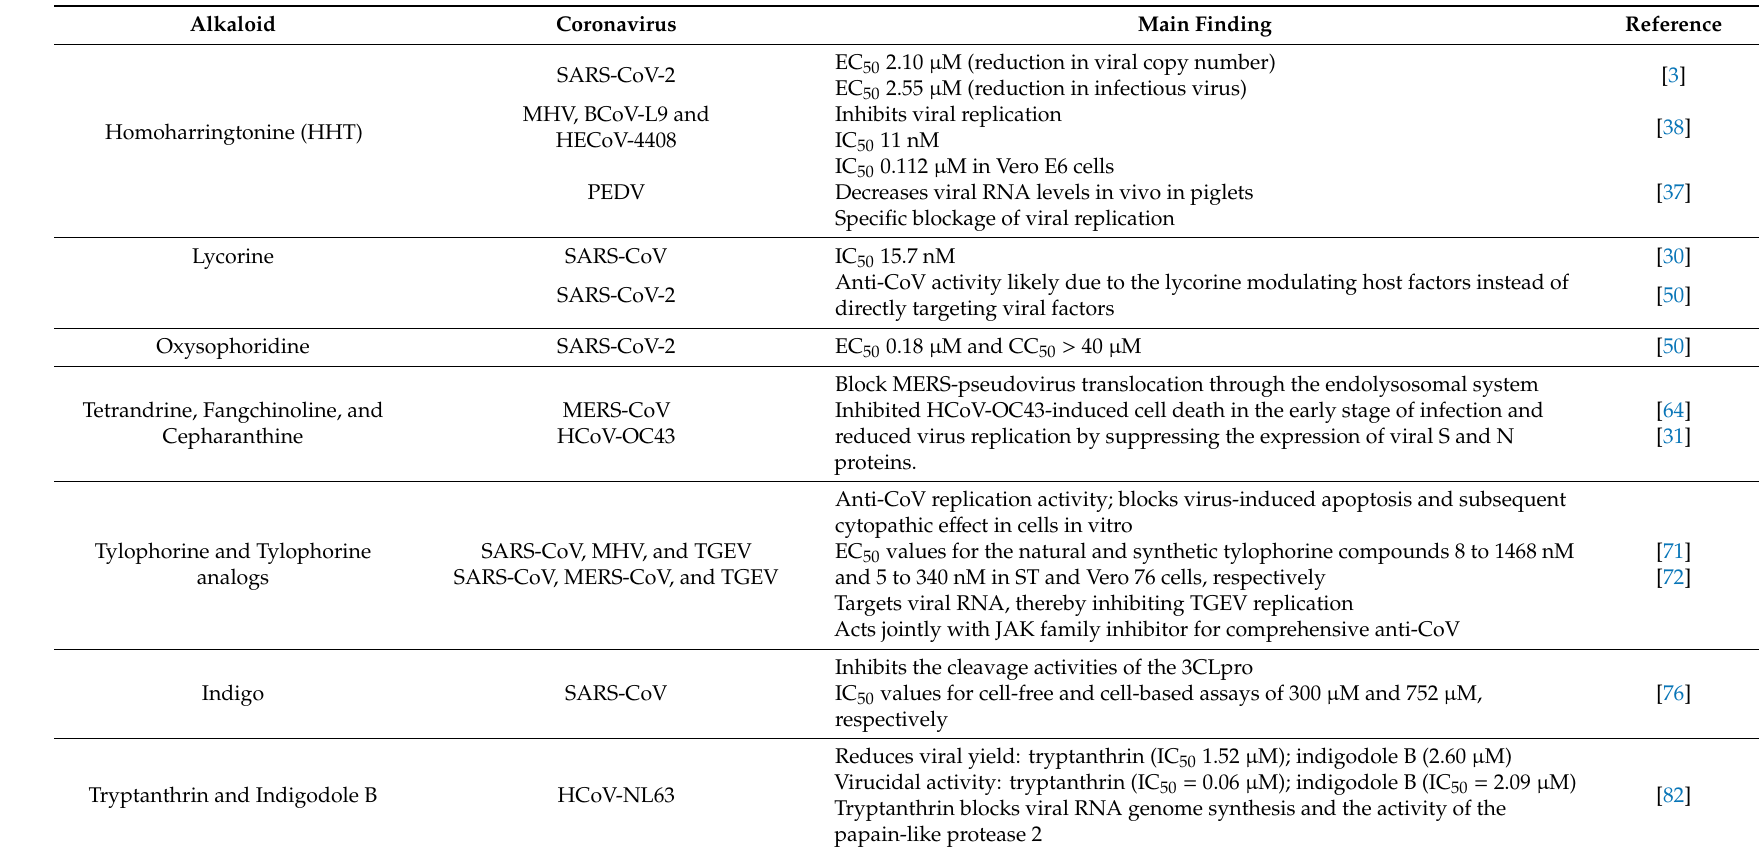
Table 1. Examples of alkaloids active against